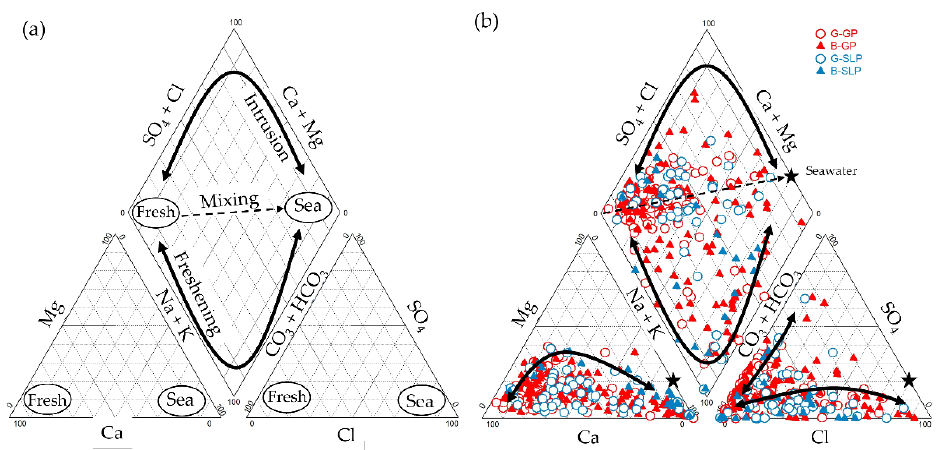
Figure 7. Piper diagrams show ( a ) the average composition of freshwater and seawater in relation to freshening, mixing, and intrusion [27,44]. The arrows correspond to the salinization paths presenting the Ca–HCO 3 type in recharge areas toward Na–HCO 3 and Na–Cl waters. The dashed line represents the evolution of freshwater toward seawater via a mixing process [27]. ( b ) Piper diagram with our groundwater samples reported according to their respective aquifer/geological province data sets. GP, Grenville Province; SLP, St. Lawrence Platform; G: granular aquifer; B: bedrock